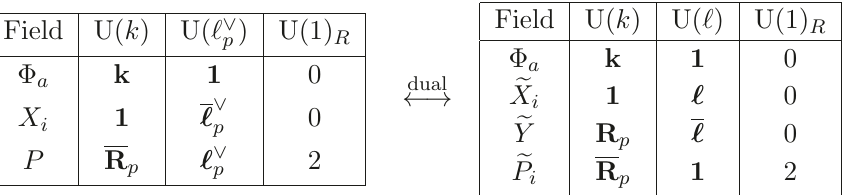
Table 3 . The left table describes matter content of the PAX model for the desingularized determi- nantal Calabi-Yau variety in G ( k, n ), where a = 1 , . . . , n , i = 1 , . . . , p , and R p is a representation in the gauge group U( k ) which describes the vector bundle . U(1) R denotes an R -charge which F p is assigned to the matter content. The right table describes matter content of the PAXY model which is a dual GLSM of the PAX